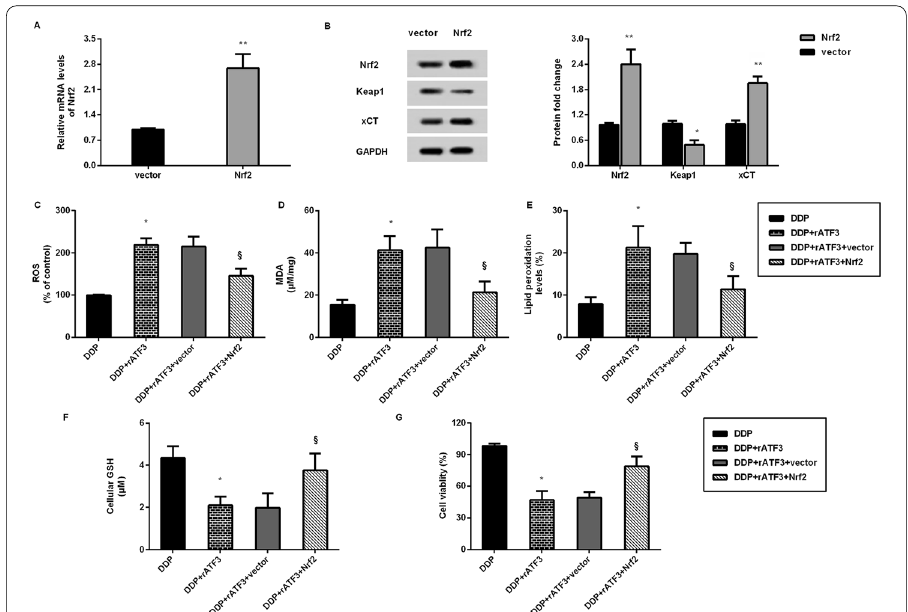
Fig. 6 Nrf2/Keap1/xCT signaling involved in ATF3-mediated ferroptosis and cisplatin resistance in GC. A The effect of Nrf2 plasmid transfection on mRNA levels of Nrf2 was analyzed by qRT-PCR. B After transfection with Nrf2 vector, protein expression of Nrf2, Keap1 and xCT was measured. * P < 0.05, ** P < 0.01 vs. vector group. C SGC7901/DDP cells were treated with ATF3 plasmids and/or Nrf2 plasmids before cisplatin exposure. Then, the levels of ROS ( C ), MDA ( D ), lipid peroxidation ( E ), GSH ( F ) and cell viability ( G ) were analyzed. * P < 0.05 vs. DDP group. § P < 0.05 vs. DDP and ATF3